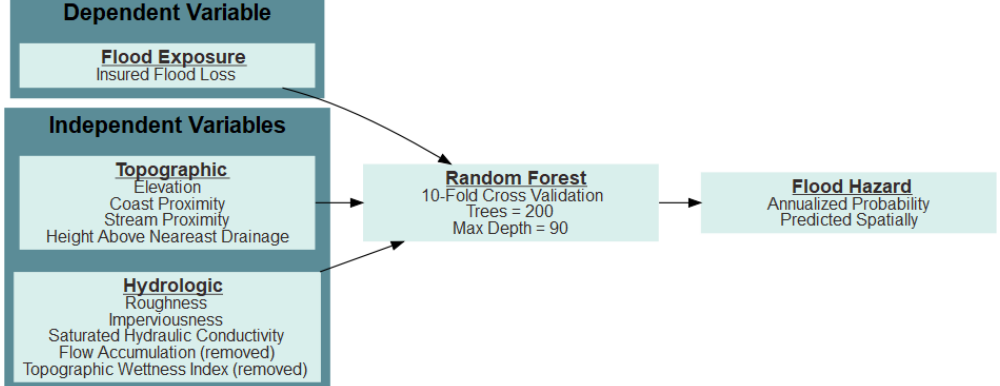
Figure 2. Conceptual framework to develop the annualized flood probability.